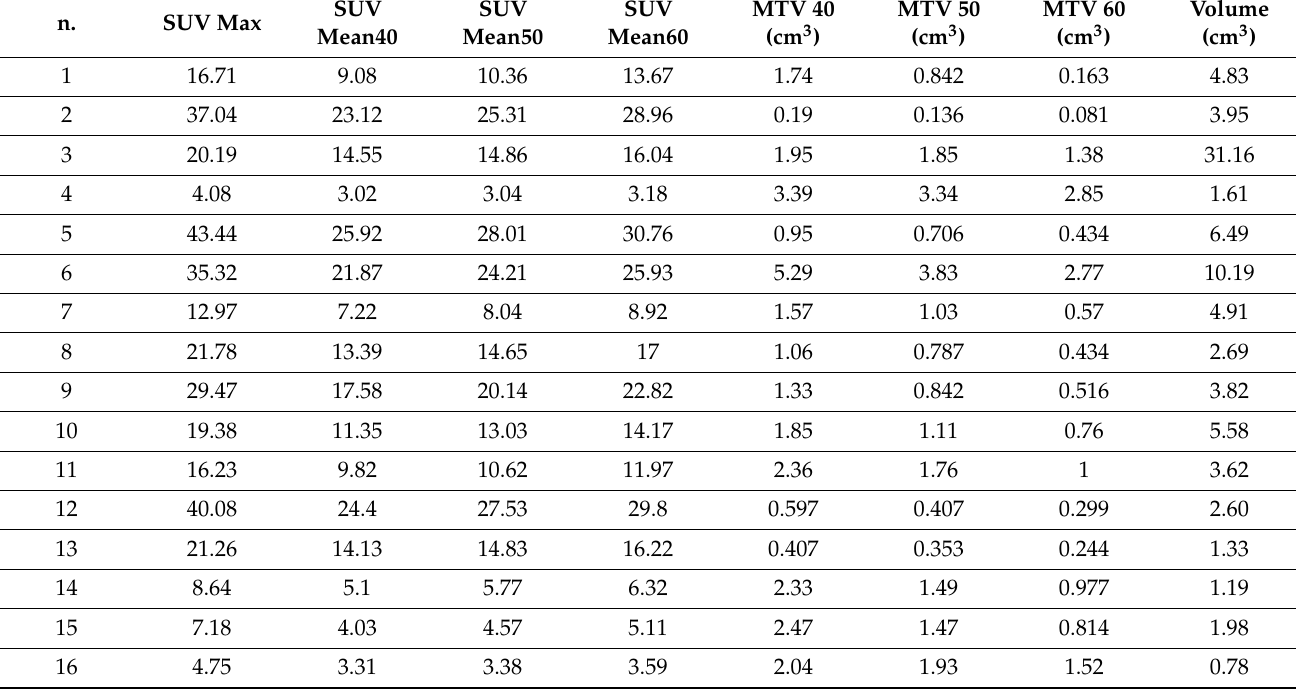
Table 3. High statistic 68 Ga-PSMA PET